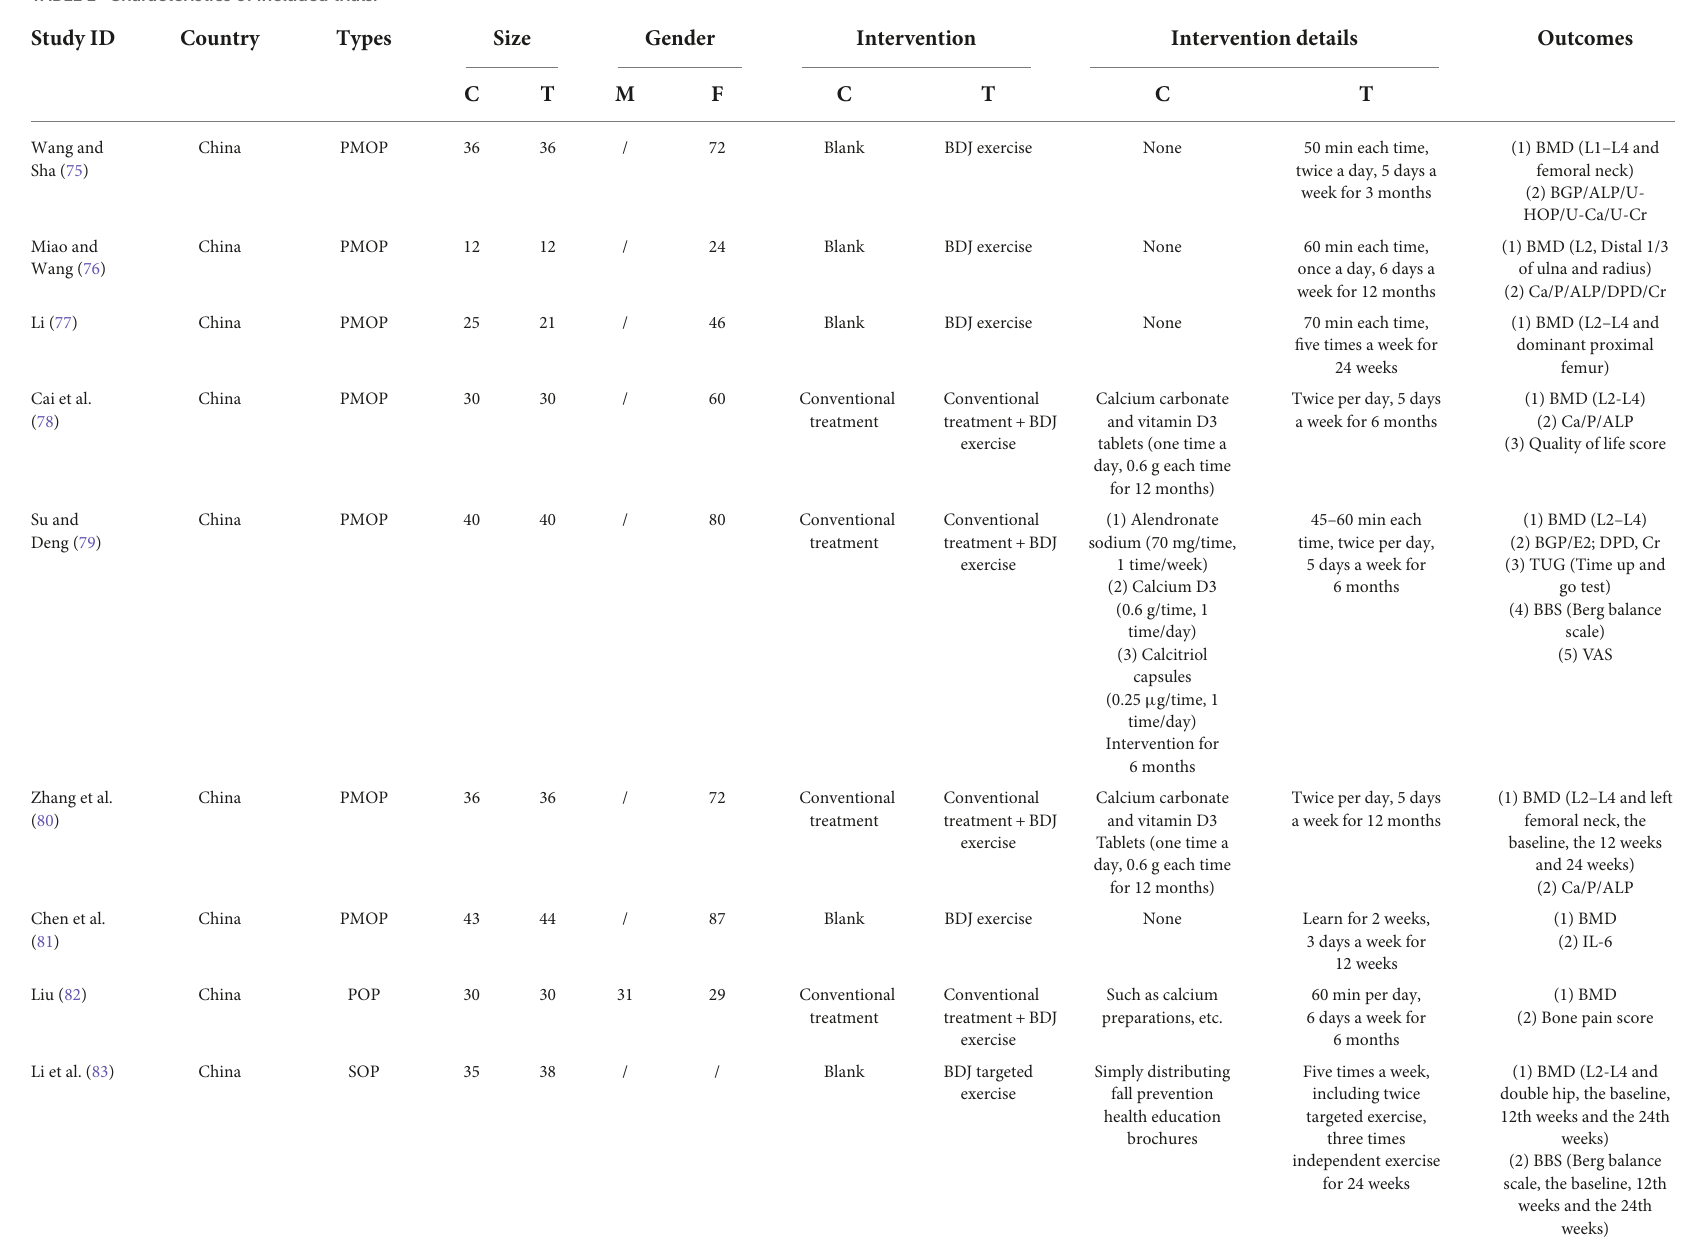
TABLE 1 Characteristics of included